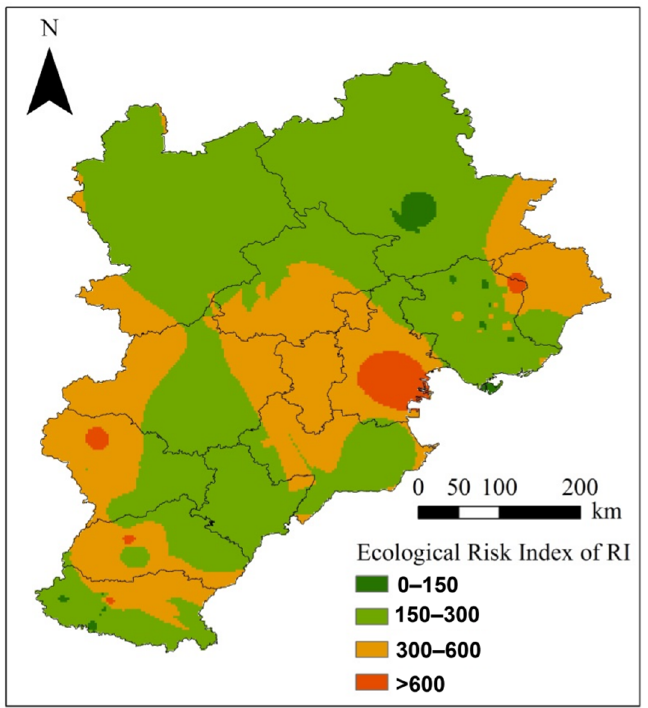
Figure 7. Distribution of RI index of coking plants causing potential ecological risk to the surrounding soil for all the PHEs.